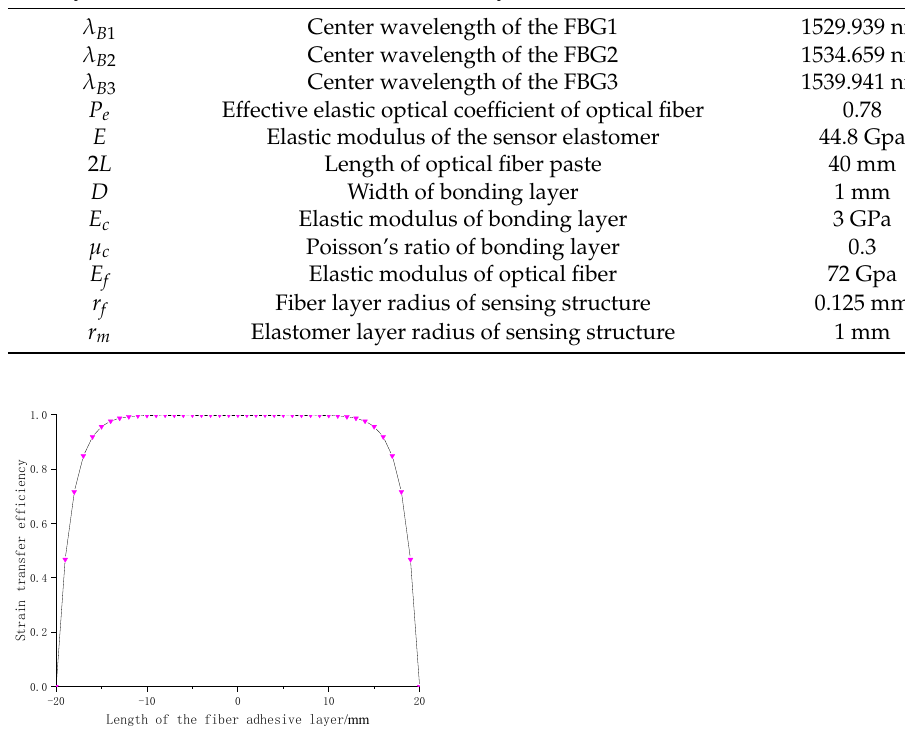
Figure 2. Axial strain transfer efficiency distribution along the length of FBG (pasting length 40 mm).